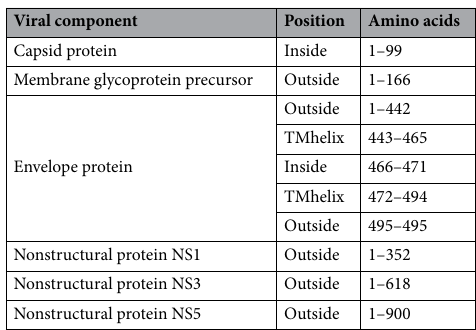
Table 4. Prediction of transmembrane helices in proteins using the TMHMM Server v2.0.